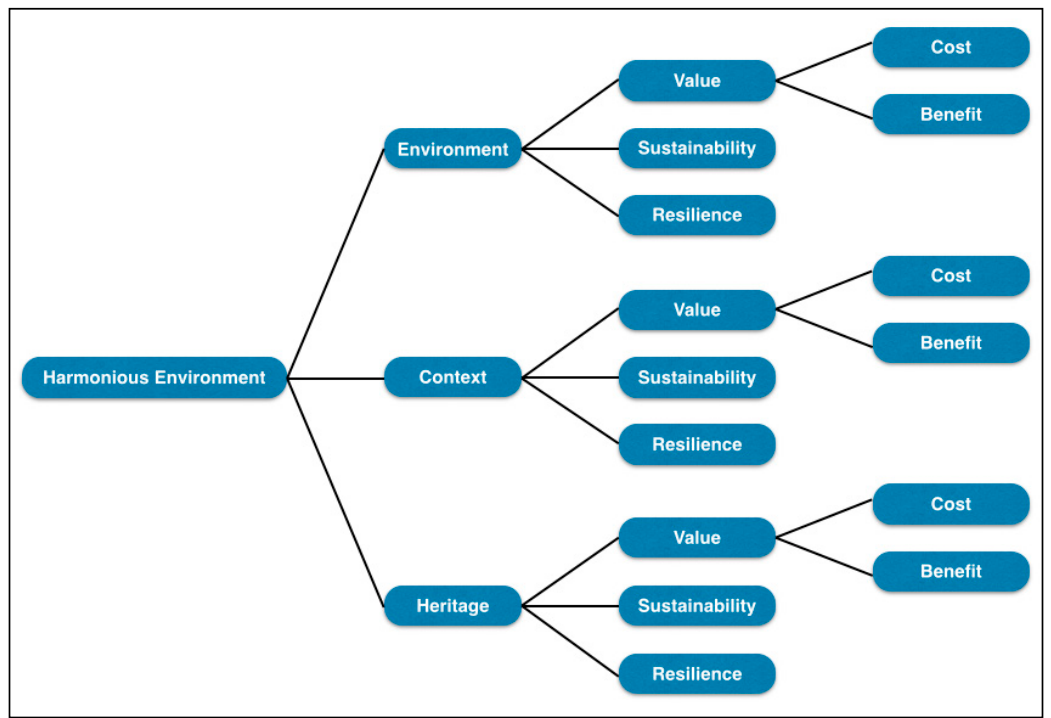
Figure 5. Value tree framework with the inclusive considerations transformed from the intervention perspective.